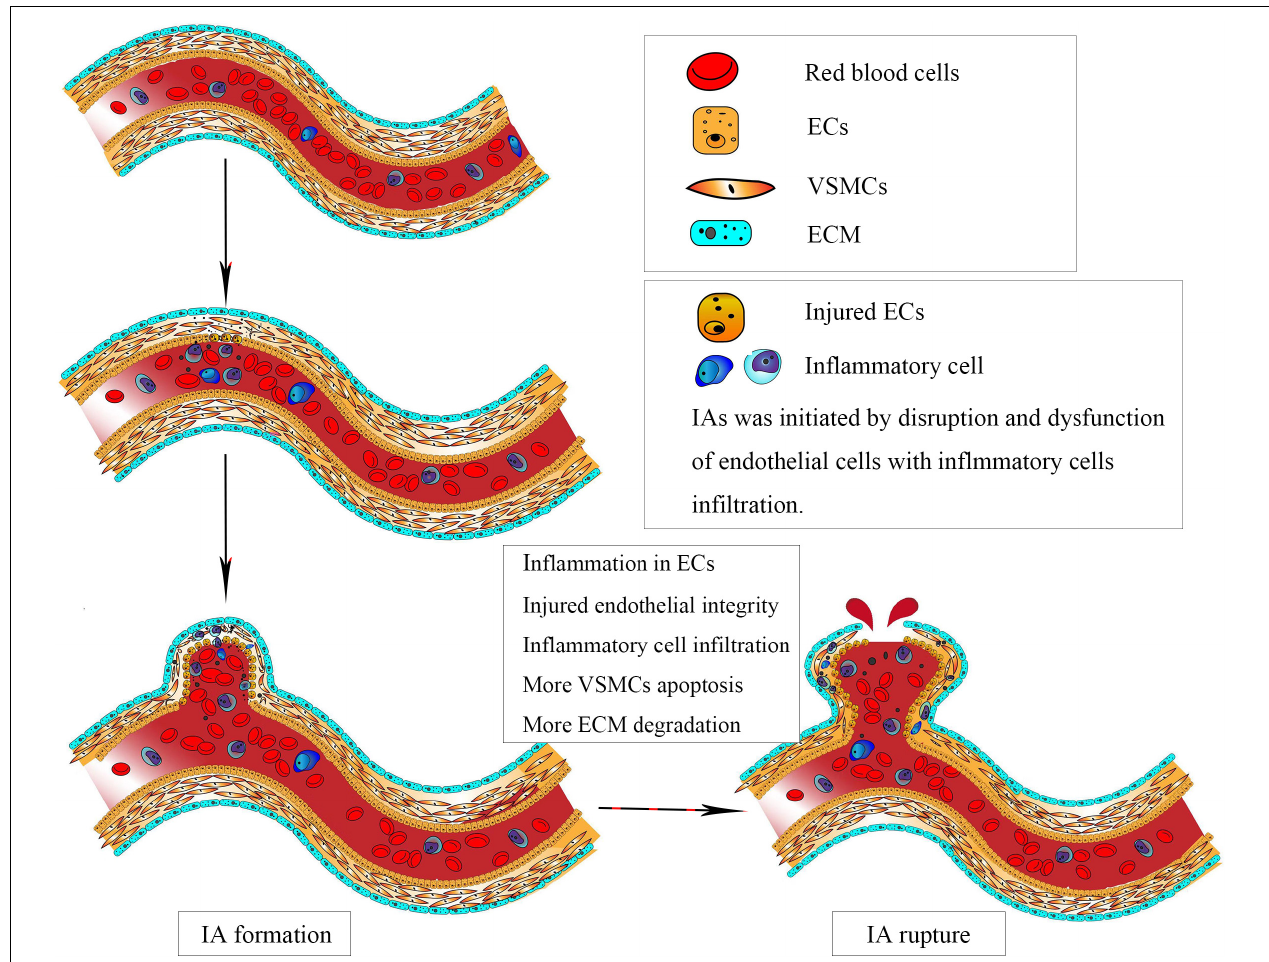
FIGURE 1 | Intracranial aneurysm (IA) was initiated by disruption and dysfunction of endothelial cells (ECs) caused by abnormal physiological wall shear stress. Subsequently, vascular smooth muscle cells apoptosis and migration, accompanied by inflammatory cell infiltration, resulted in degradation of vascular wall, leading to the progression and eventual rupture of